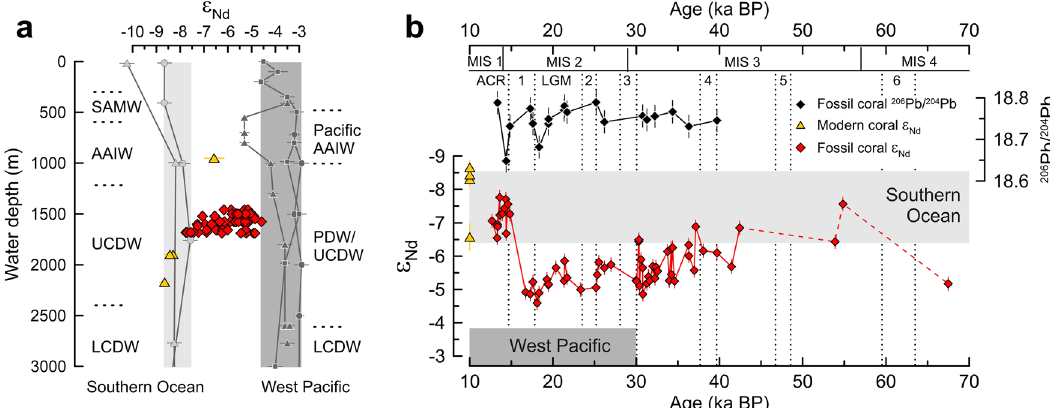
Fig. 2 Modern and fossil Tasman cold-water coral data. a Coral Nd isotope data (symbols and error bars as in b ) compared to modern seawater Nd isotope pro fi les from the Southern Ocean 40 and West Paci fi c 38 (symbols as in Fig. 1). Light and dark gray bars indicate the range of Nd isotope signatures ( ε Nd ) of water masses between 400 and 3000 m water depth in the Southern Ocean 40 and in the West Paci fi c 38 , respectively. Also shown is a pro fi le from North Paci fi c station BO-1 (gray squares; 40°N, 160°E) 98 . Error bars for seawater Nd isotope data represent the 2 s uncertainties reported in the original publications 38,40,98 . SAMW Subantarctic Mode Water, AAIW Antarctic Intermediate Water, UCDW Upper Circumpolar Deep water, LCDW Lower Circumpolar Deep Water, PDW Paci fi c Deep Water. b Time series of fossil coral ε Nd compared to Pb isotope ( 206 Pb/ 204 Pb) data from the same specimens 50 . Error bars represent the analytical uncertainties of coral Nd (Methods) and Pb isotope data 50 . A light gray bar outlines the 2 SD of Nd isotope compositions of CDW from the Indian Ocean and the Drake Passage between 10 and 70 ka BP 34,57,59 (see Fig. 3b for more details). The dark gray bar represents the 2 SD of past seawater Nd isotope compositions from north of the Tasman Sea for the time interval between 10 and 30 ka BP 71,72 . The numbers and boundaries of Marine Isotope Stages (MIS) are shown along the top axis. Dotted lines and numbers indicate Heinrich Stadials. ACR Antarctic Cold Reversal, LGM Last Glacial Maximum. Ages are reported in thousand years before the present (ka BP, present = 1950). Modern coral data include one replicate (see Supplementary Data